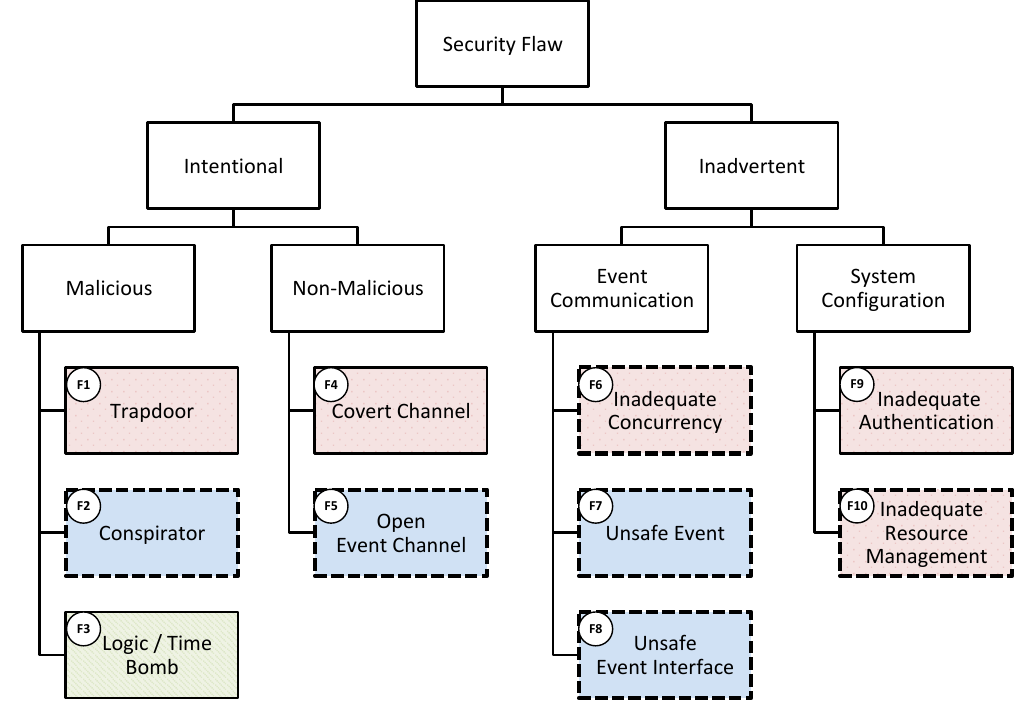
Figure 1. Security Flaw Taxonomy for event-based system (EBS). The Red boxes indicate the flaws adapted from the original taxonomy. The Blue boxes indicate the newly added flaws. The Green box indicates the flaw unchanged from the original taxonomy. The circled labels indicate the assigned number for each